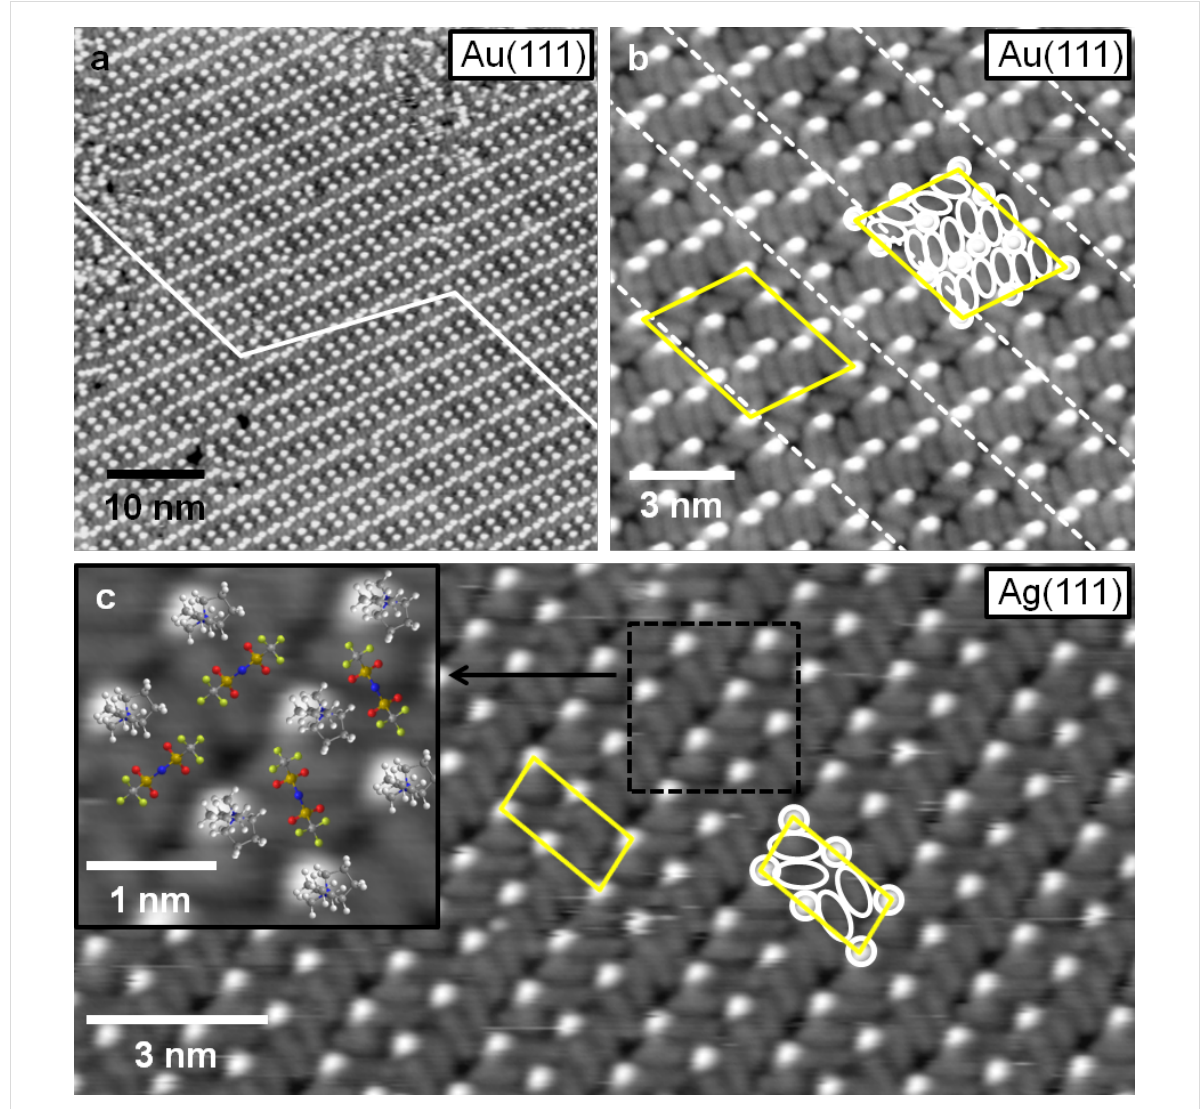
Figure 4: High resolution STM images of the 2D crystalline structures on Au(111) (a, b) and Ag(111) (c). The unit cells are marked with yellow lines. Both structures are composed from round shaped and longish protrusions, which are marked with white circles and ellipsoids. In (a) the white line and in (b) the dashed lines mark the zig-zag lines of the Au(111) reconstruction, which are visible through the 2D crystalline structure of the IL adsorbates; the inset of (c) shows an enlarged part of image (c) with superimposed ball and stick models of [BMP][TFSA] (a: T = 139 K, U T = − 1.20 V, I T = − 0.060 nA; b: T = 116 K, U T = − 0.71 V, I T = − 0.10 nA; c: T = 134 K, U T = − 0.37 mV, I T = 110 pA).